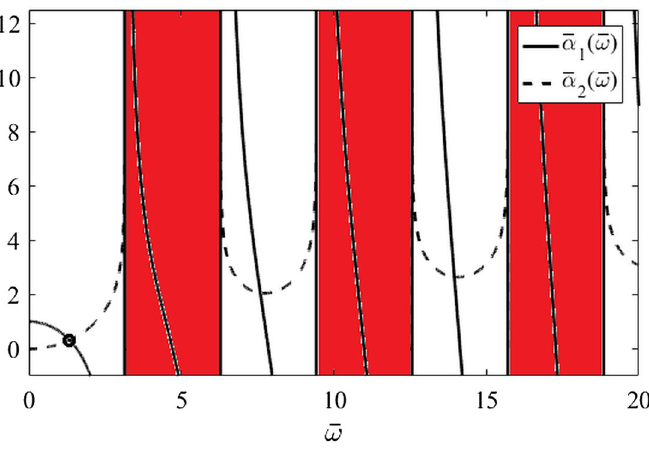
Figure 7. Intersections of α 1 (ω) and α 2 (ω) to get s i ∈ C \ R (Theorem 2, Corollary